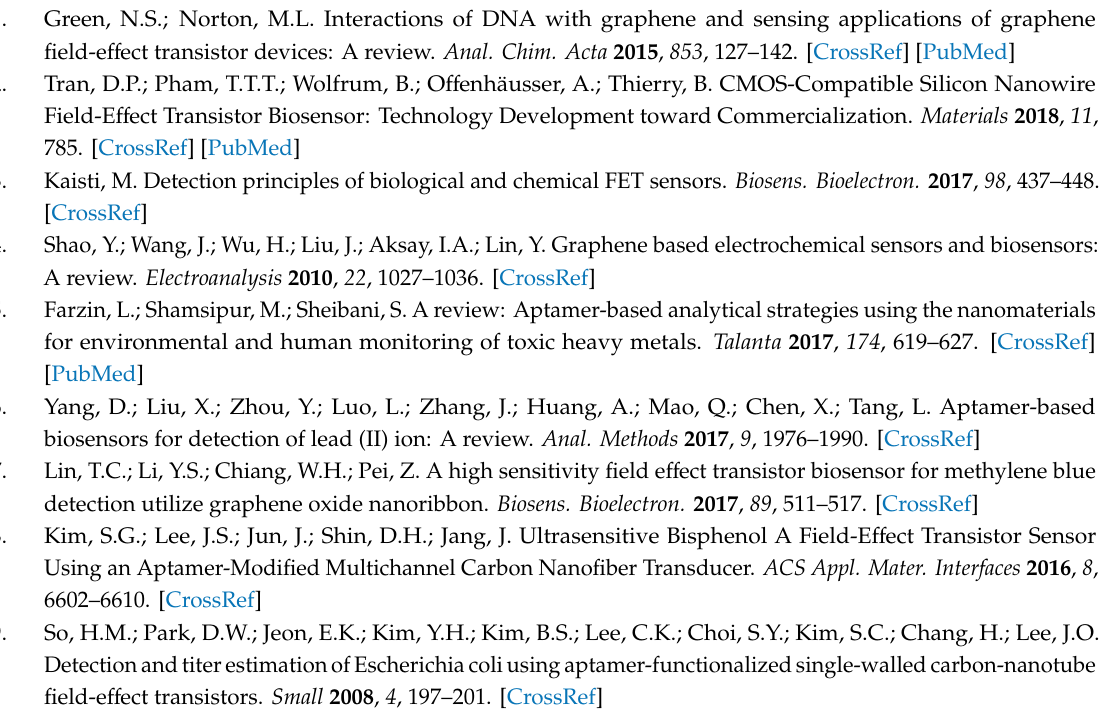
Figure S1: Cyclic experiments for LSA immobilization and the detection of standard Pb2 + solutions, Figure S2: Additional characterizations of Raman and SEM, Figure S3: The C1s core spectra and their peak-fitting curves, Figure S4: Fit analysis of O1s core spectra for XPS sampls, Figure S5: Fit analysis for N1score spectra for the six samples, Figure S6: Electronic transferring measurements of the studied rGO-COOH based SgFET and its counterparts based on rGO and purchased graphene paste (pGp), Figure S7: Diagram of principle in SgFET. Supplementary data related to this article can be found at online Library of